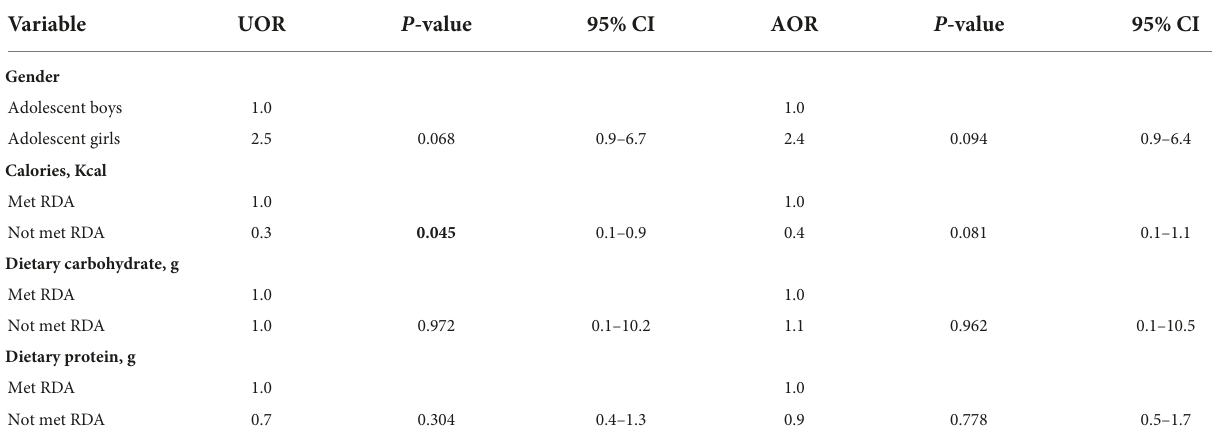
Overweight/Obesity, BMI ≥ 25.0 Kg/m